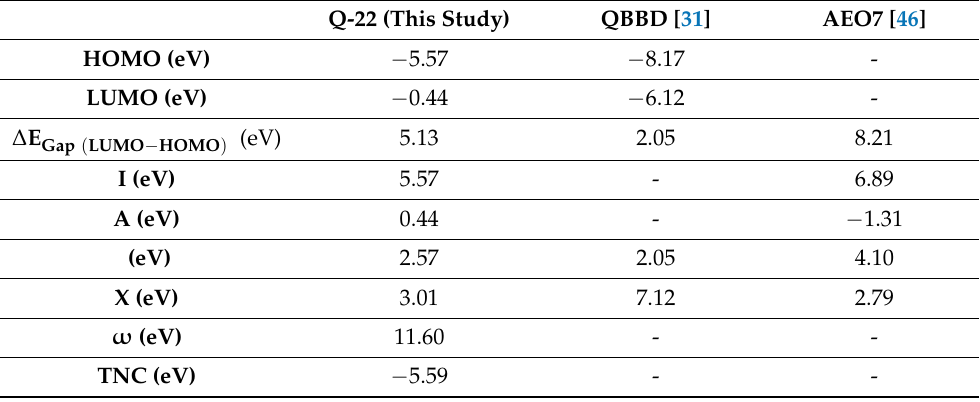
Table 7. Quantum parameters of Q-22 calculated at the B3LYP/6-311+g(d,p) level of theory and com- pared with other green surfactants in the literature (QBBD and AE07 calculated at B3LYP/6 − 31+g(d,p) and B3LYP cc-pvdz basis set,